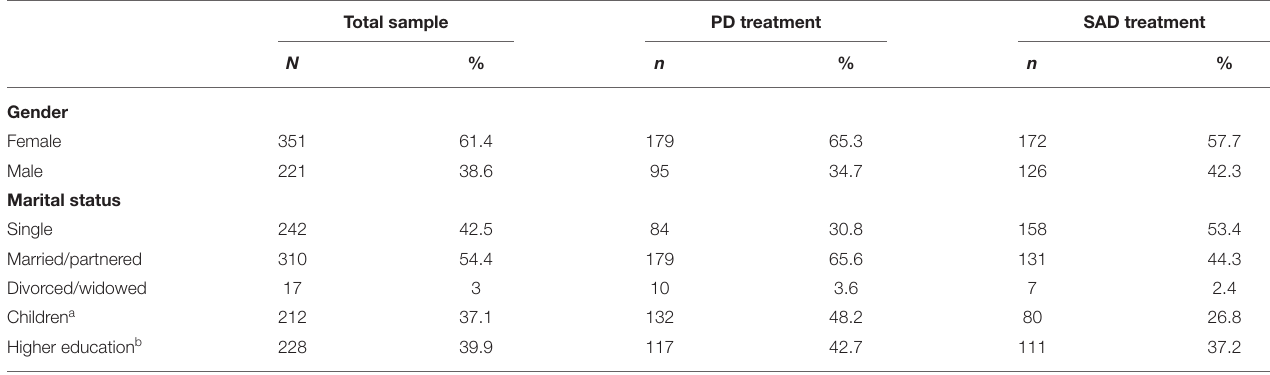
Total sample PD treatment SAD